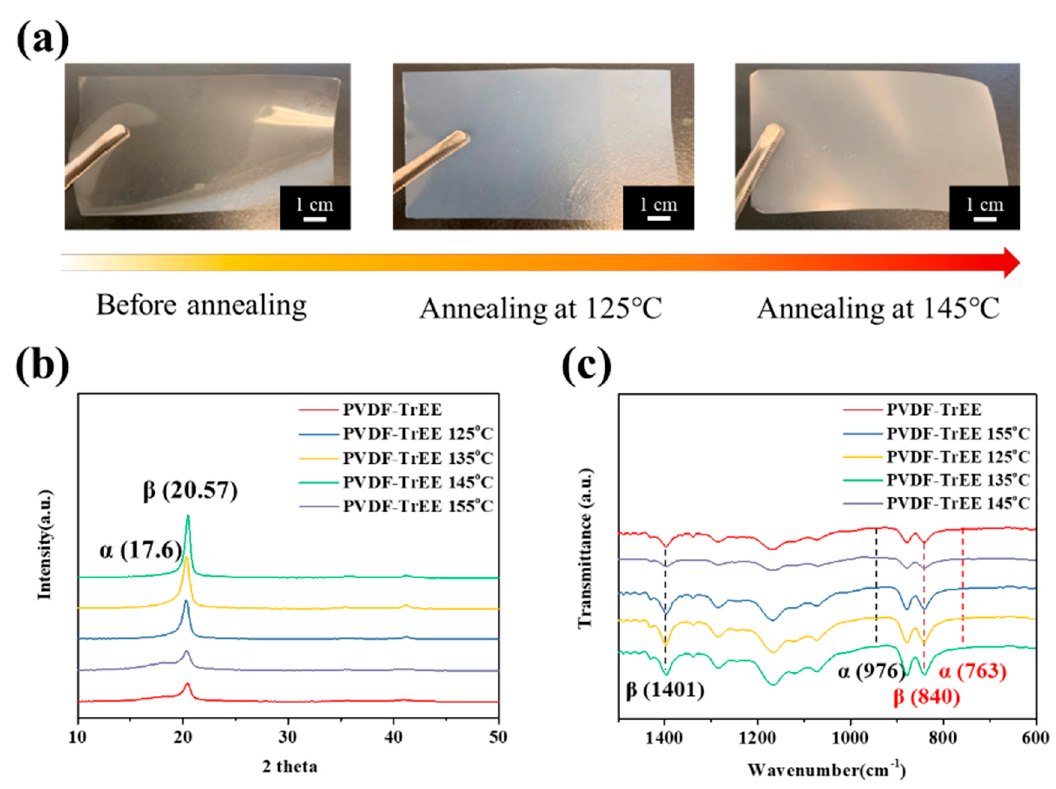
Figure 2. ( a ) Appearance, ( b ) XRD patterns, and ( c ) FTIR curves of PVDF-TrEE after different annealing temperatures.